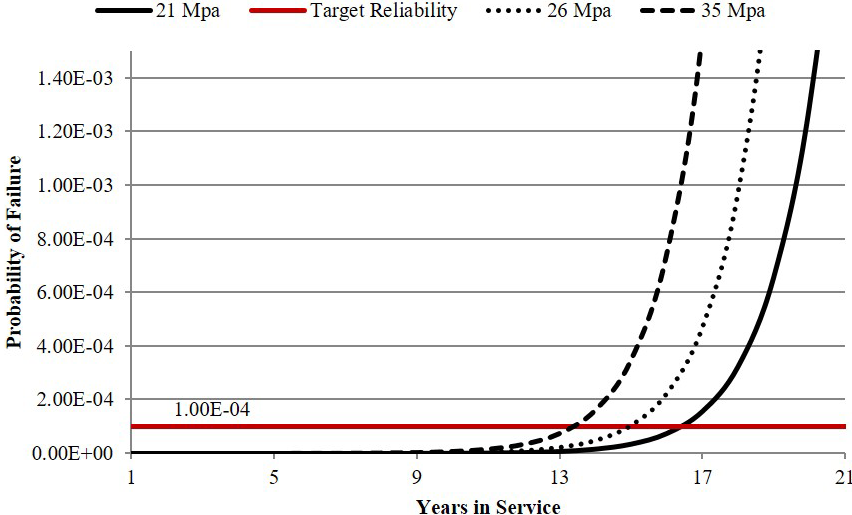
Figure 27. Fatigue reliability (FM) of a welded joint in an offshore structure for three different constant-amplitude stresses.